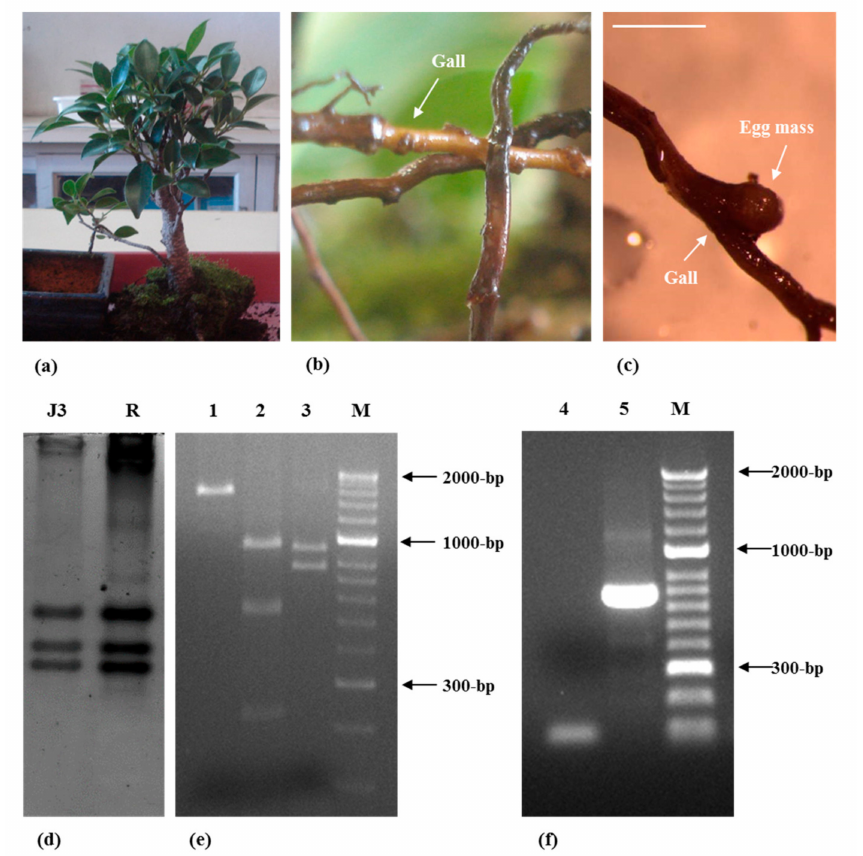
Figure 1. Meloidogyne javanica parasitizing Ficus microcarpa . ( a ) F. microcarpa . ( b , c ) F. microcarpa